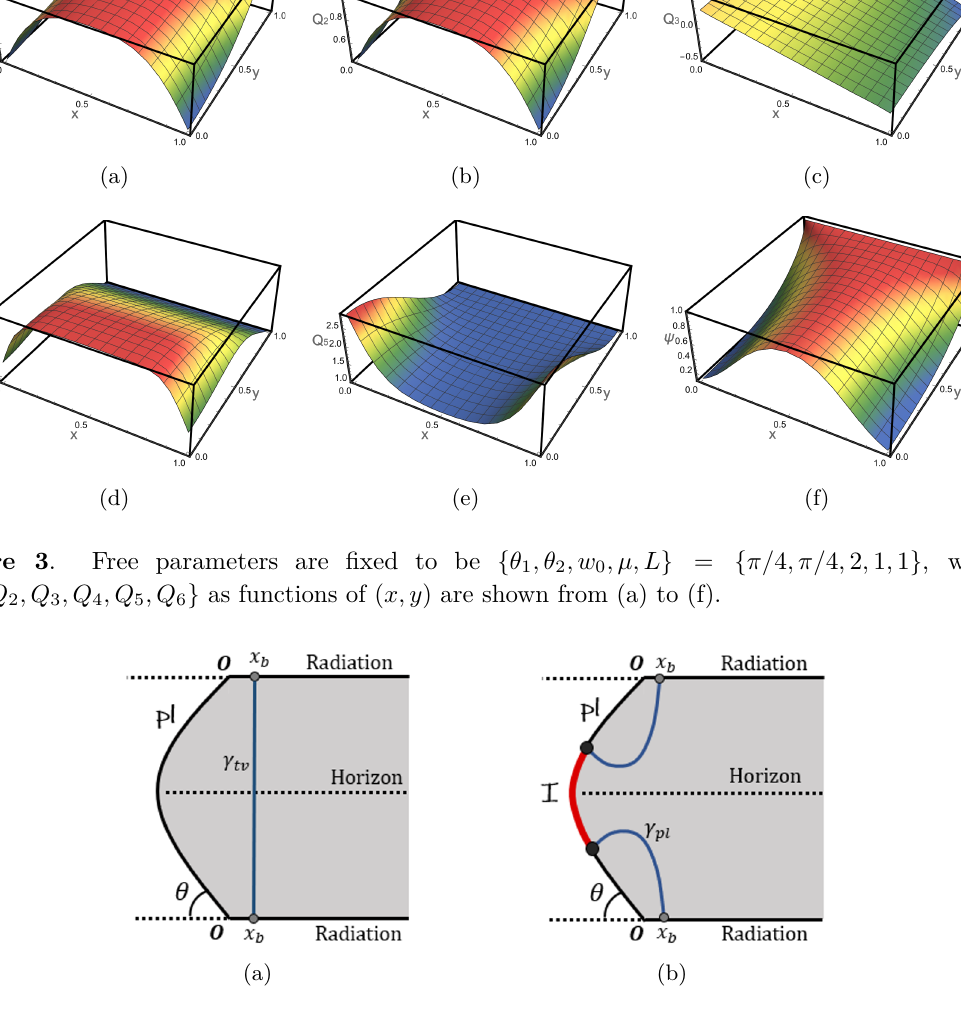
Figure 4 . In the ordinary doubly holographic model, (a): no island emerges at early times; (b): an island emerges after Page